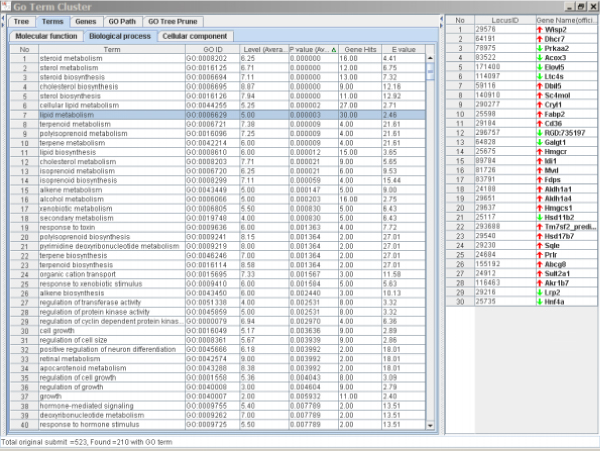
Significantly altered terms and the genes associated with lipid metabolism caused by AA treatment in rat liver. The left panel is the Terms Window and the right panel is the Genes Window. The major genes in the list were up-regulated.